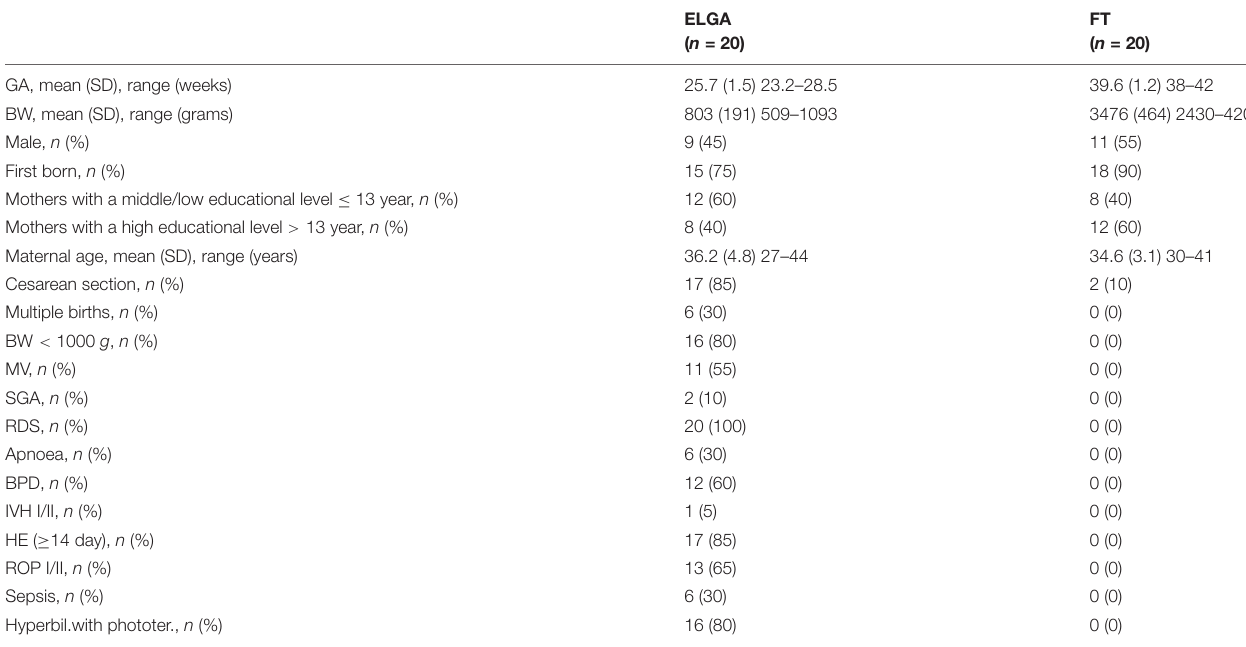
TABLE 1 | Biological, socio-demographic, and medical characteristics of